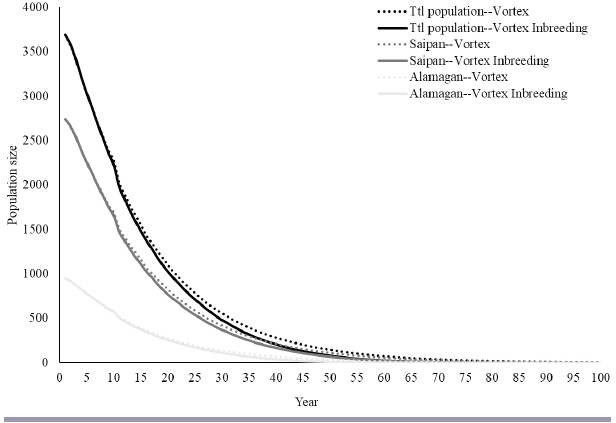
Fig. 1 . Average Nightingale Reed-warbler ( Acrocephalus hiwae ) population size over 100 years for Saipan, Alamagan, and the total population. Note that because of the length of time since population estimation (~10 years), these trajectories